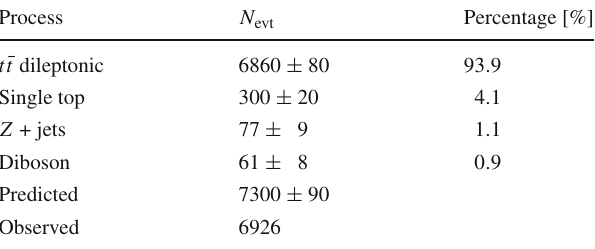
Table 3 Expected composition of the selected sample in terms of num- ber of events ( N evt ) and fractions (%) of different processes. Uncertain- ties are statistical